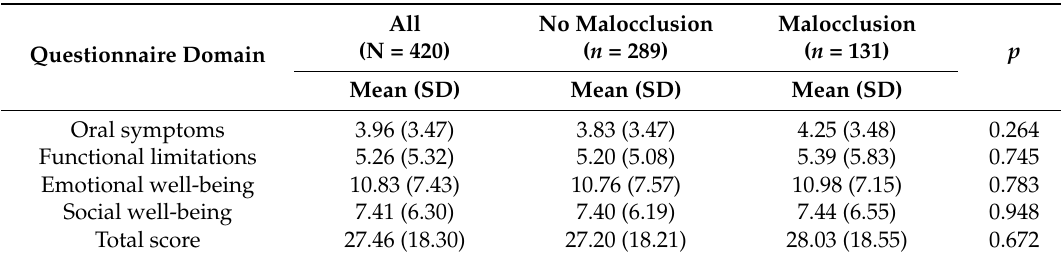
Table 3. Associations between malocclusion and scores for the Child Perceptions Questionnaire and its four individual